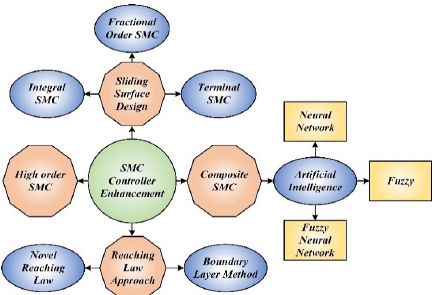
Figure 2. Enhancement made in sliding mode control (SMC) [30] .